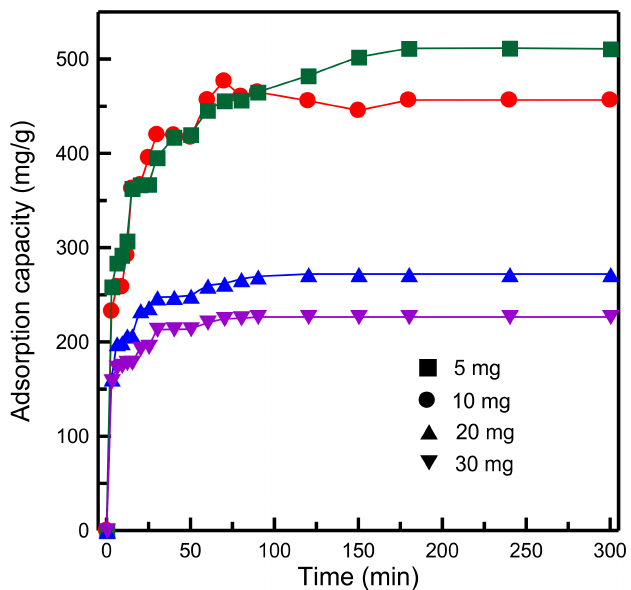
Figure 12. Influence of dosage of adsorbent on adsorption capacity of